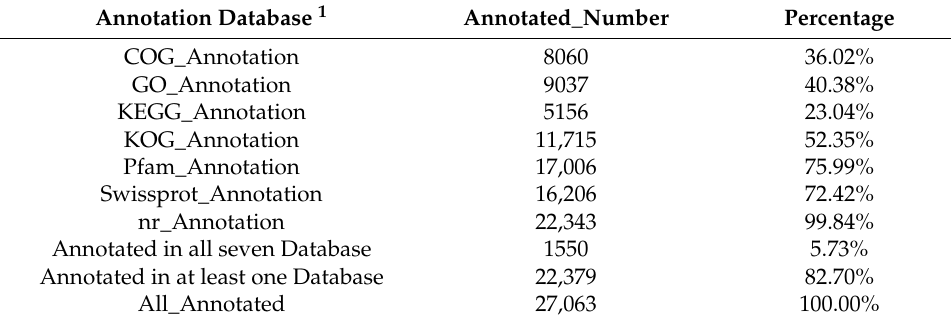
Table 1. Summary of the gene annotations in seven